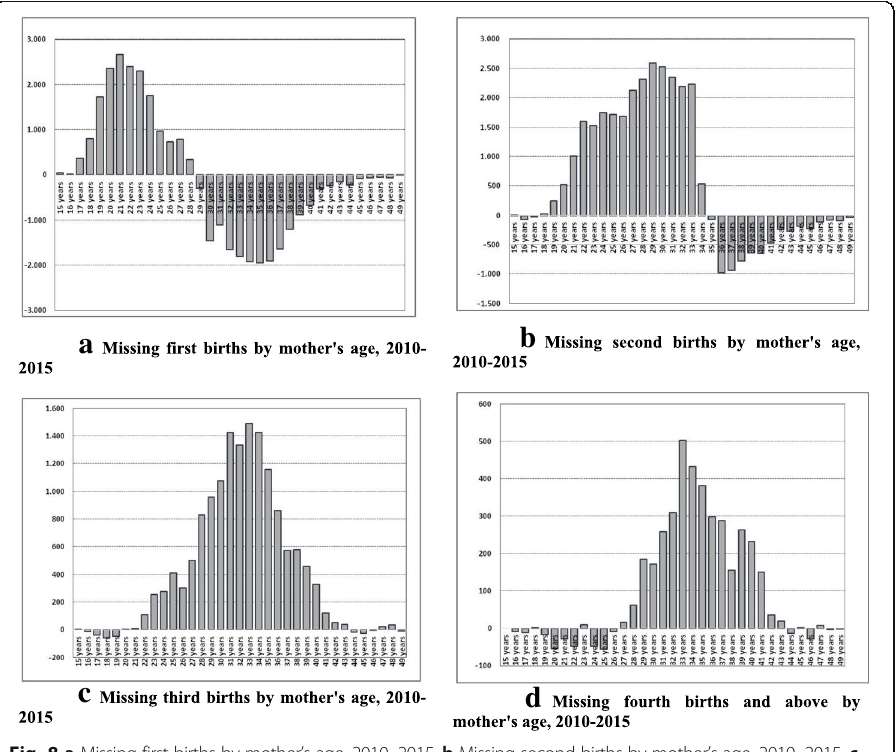
Fig. 8 a Missing first births by mother ’ s age, 2010 – 2015. b Missing second births by mother ’ s age, 2010 – 2015. c Missing third births by mother ’ s age, 2010 – 2015. d Missing fourth births and above by mother ’ s age, 2010 –